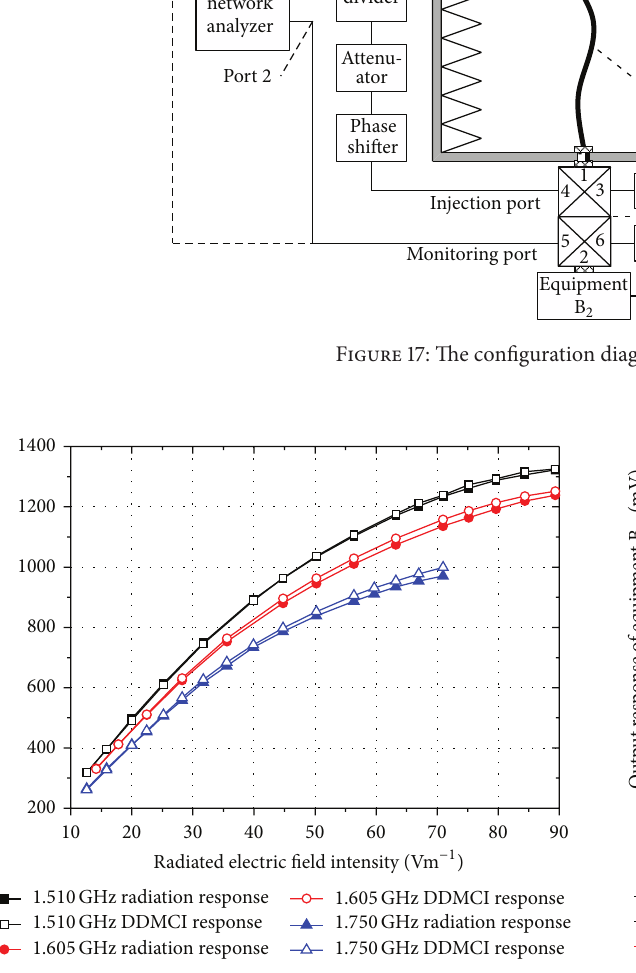
Figure 18: The radiation and DDMCI response curve of equipment A 2 .